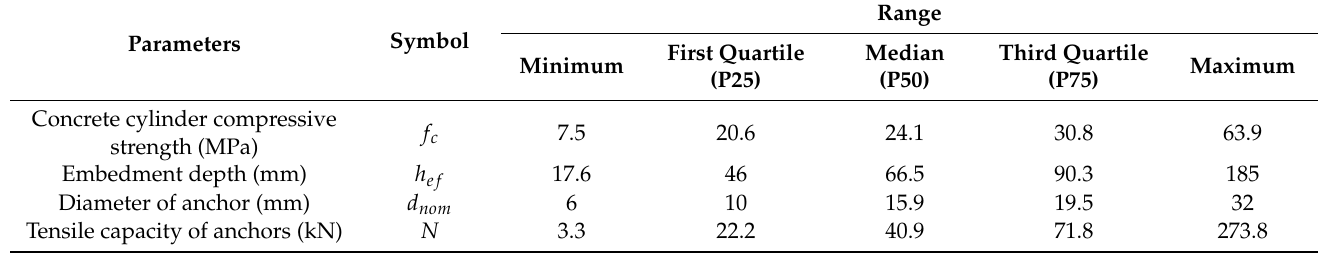
Table 2. Statistical summary of the training and testing dataset used for the model development.